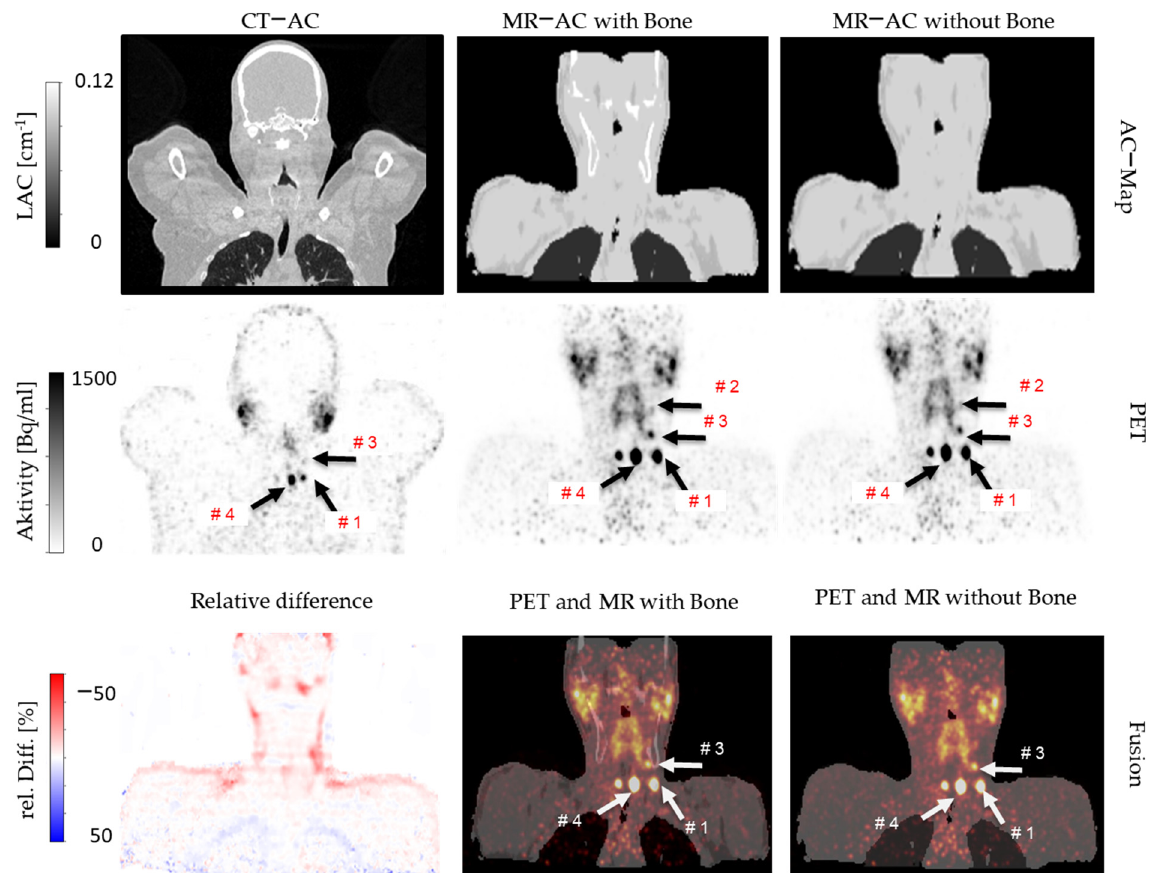
Figure 7. A patient example, who underwent a whole ‐ body 124 I − PET/CT and subsequent a head ‐ neck 124 I − PET/MR. A tt enuation correction maps (AC maps, upper row), corresponding PET data (middle row), fusion images, and a relative difference image (lower row) are given. Exemplarily, three of five measured lesions are marked in the PET images (lesions #1, 2, 4 marked with white arrows, here visible in PET/CT and PET/MR data). Relative differences in PET signal between MR ‐ based AC with vs. without bone show only small positive differences (red color) mostly in regions where the bone atlas added bone (spine and skull).